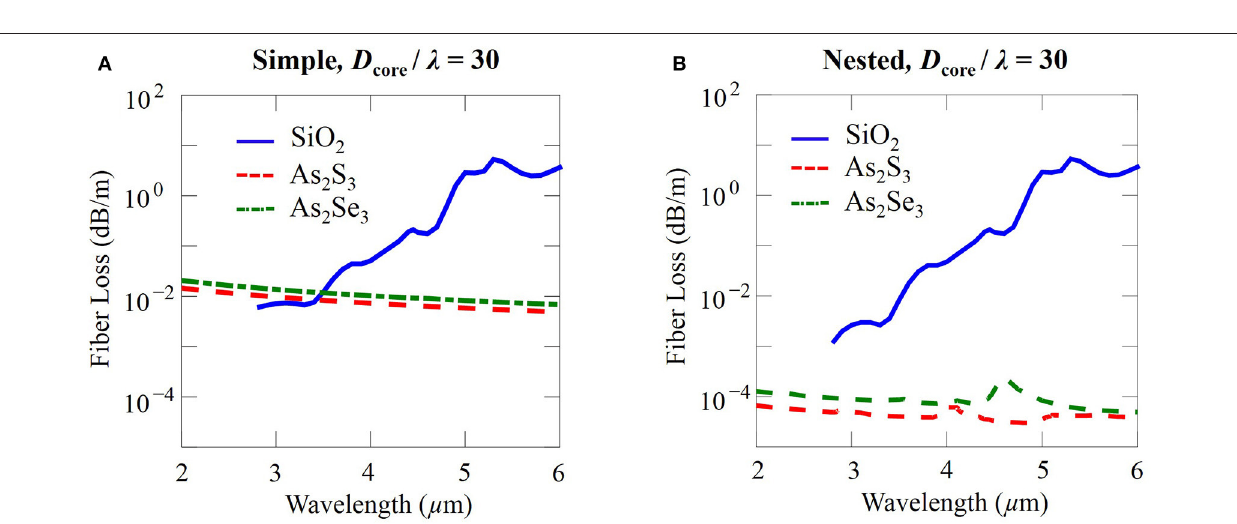
As 2 S 3 at wavelengths of 2.8 µ m, 2.92 µ m, and 4.05 µ m